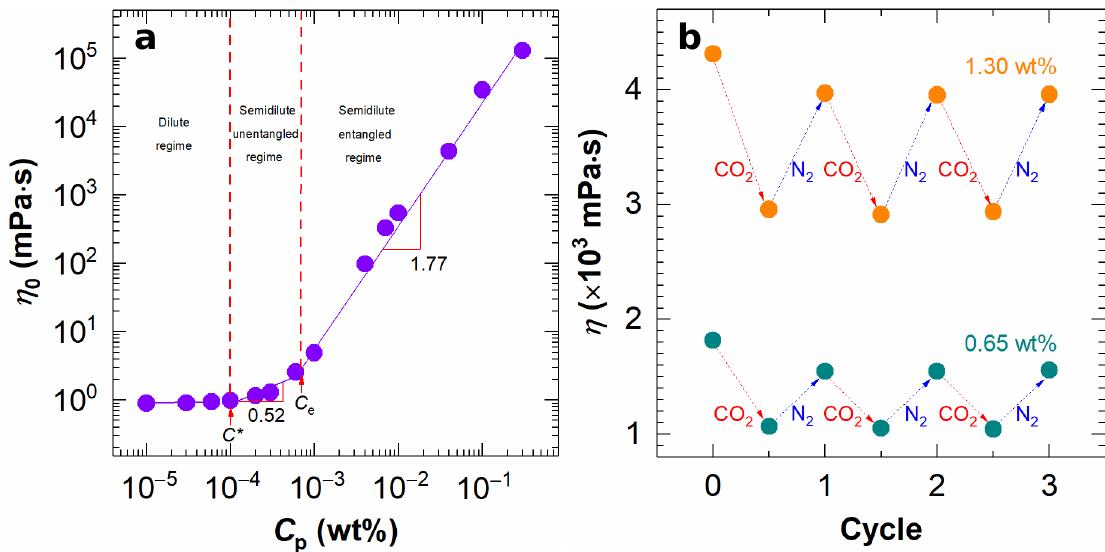
Figure 1. ( a ) Variation of η 0 with NaPAA concentration in pure water, and ( b ) the viscosity alternation of 0.65 and 1.30 wt% NaPAA aqueous solutions at shear rate of 10 s − 1 upon alternately bubbling CO 2 and N 2 at 25 °C.